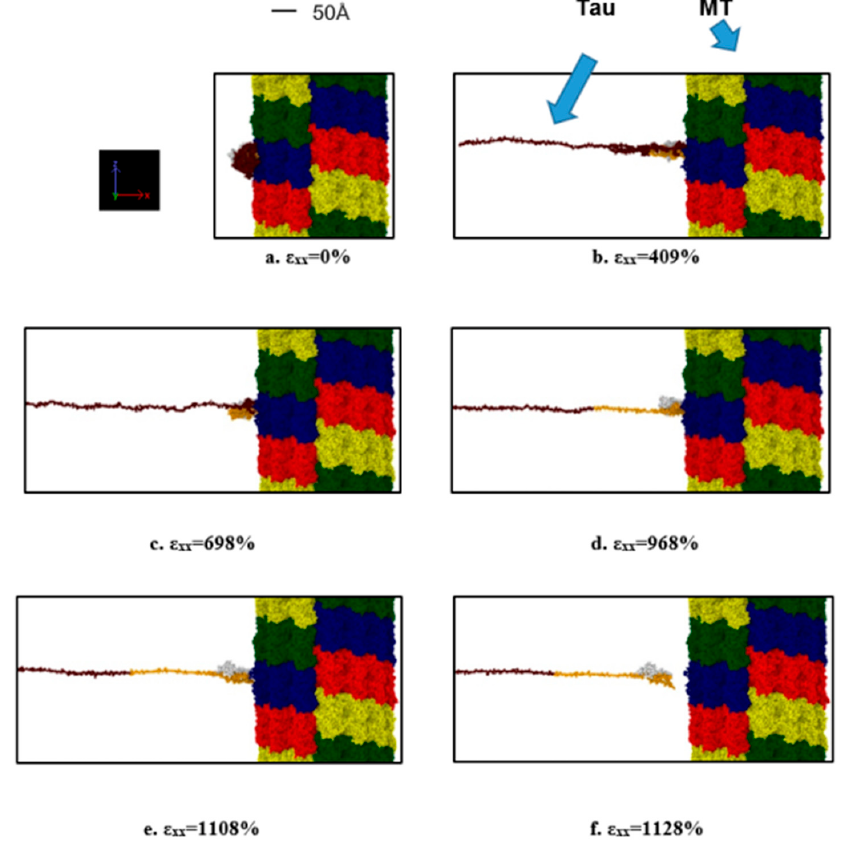
Figure 6. Observation during the pulling of single tau towards the − x-direction (strain rate: 2 × 10 9 s − 1 ) away from MT surface. ( a ) Initial stage (strain: 0%), ( b ) unfolding of tau projection domain (strain: 409%), ( c ) stretching of tau projection domain (strain: 698%), ( d ) stretching of MT binding region (strain: 968%), ( e ) onset of separation (strain: 1108%), ( f ) after complete separation (strain: 1128%). Color legends: Red, blue, green, and yellow: repeating helical units of MT, maroon: projection domain of tau, orange: MT binding site atoms of tau (including the inter-repeats), white: N terminus tail of